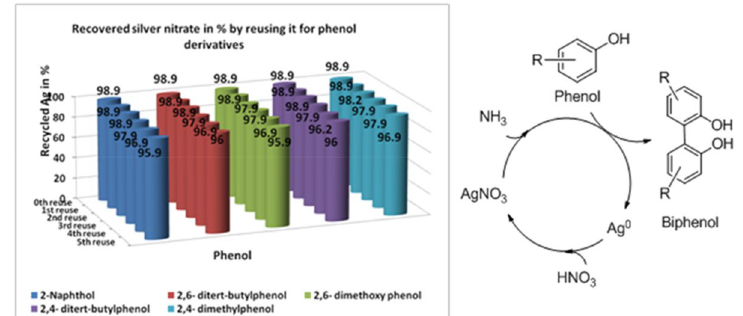
Figure 1. A graph of recovered silver nitrate (%) after each C–C oxidative coupling reaction between phenol or naphthol derivatives. Schematic recovery of silver is shown on right hand